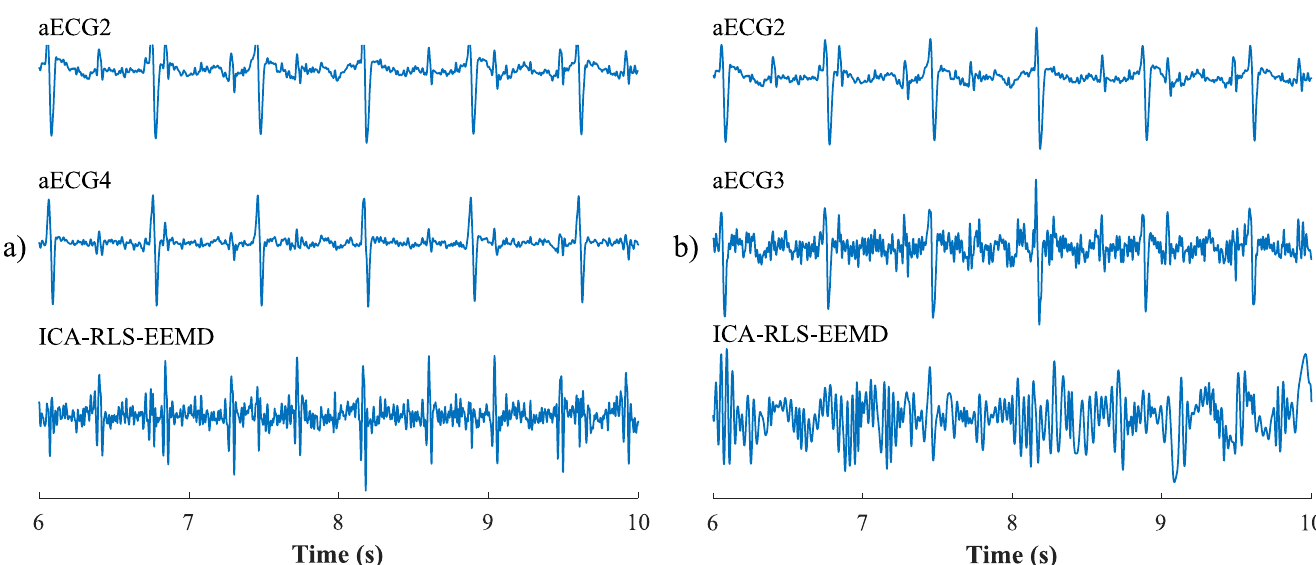
Fig 15. An example of the effect of the input aECG signal selection on the resulting signal quality: a) optimal selection of input aECG signals (aECG2 and aECG4), the resulting extracted signal is of a high quality; b) inappropriate combination of input signals (aECG2 and aECG3) causing the method to fail to extract fECG signals.